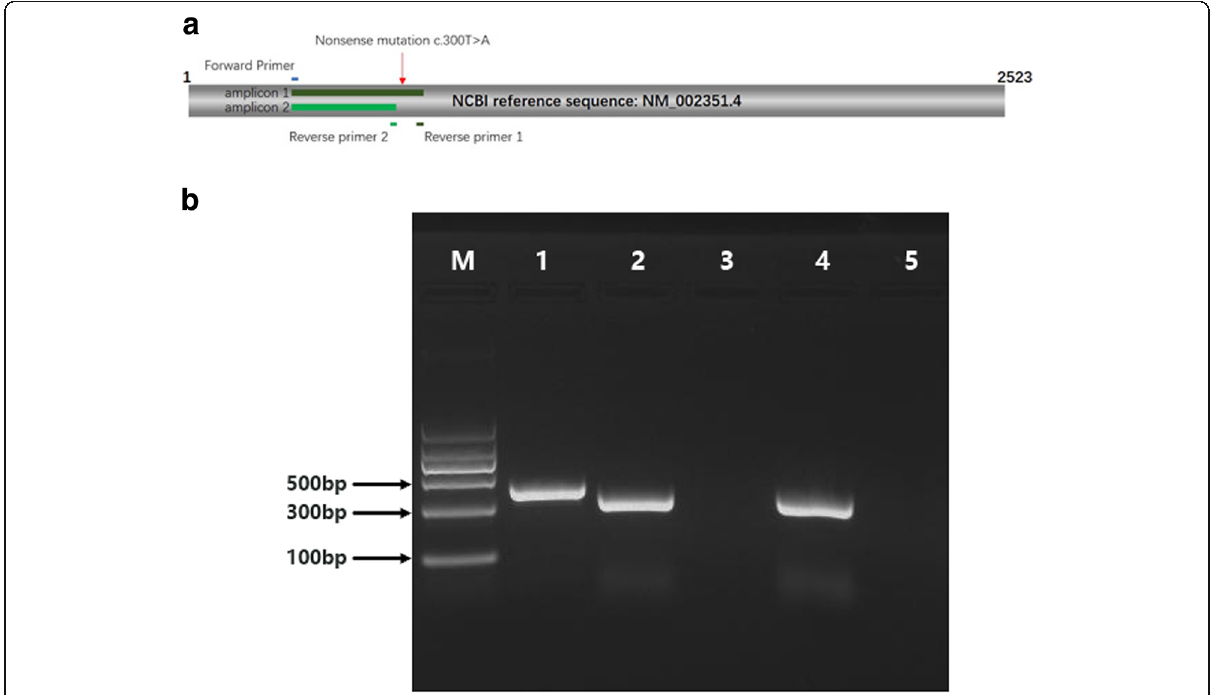
Fig. 2 RT-PCR analysis of the SH2D1A gene. a Primer pairs and amplicons in the cDNA sequence of the SH2D1A gene. b Gel electrophoresis of RT-PCR products for the SH2D1A gene. M: DNA marker; lane 1: amplicon 1 of the control sample; lane 2: amplicon 2 of the control sample; lane 3: amplicon 1 of the patient ’ s sample; lane 4: amplicon 2 of the patient ’ s sample; lane 5: negative